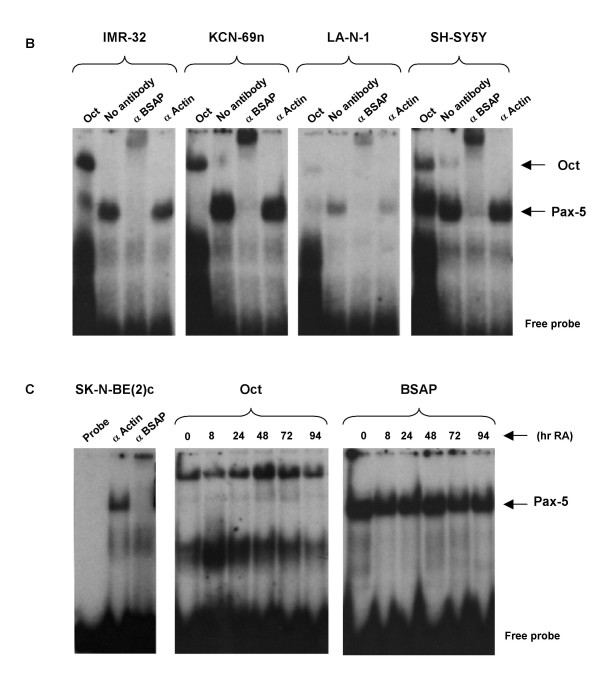
Neuroblastoma cells express constitutive levels of Pax-5 proteins.  Panel (B) shows EMSA analysis of Pax-5 (BSAP) super-shift using nuclear  extracts from a set of neuroblastoma cell lines as indicated after addition  of either no, anti-Pax-5 or anti actin antibody. Panel (C) shows auto  radiogram with EMSAs using either a Pax-5 or an Oct binding site and nuclear  extracts from SK-N-BE(2)c (neuroblastoma) cells stimulated to undergo  differentiation with retinoic acid (RA) for the indicated times. The left  panel displays a super-shift experiment using either actin or Pax-5  antisera.